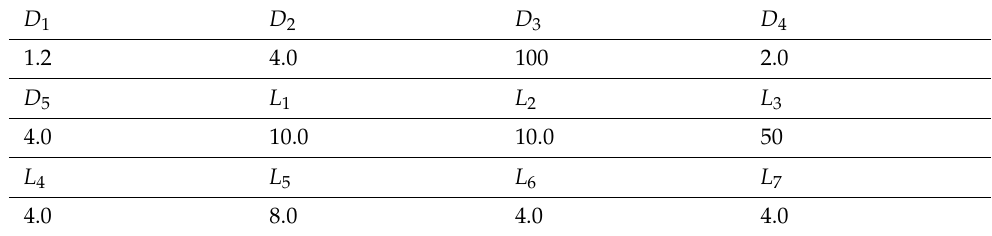
Figure 2. The antenna and the pressurizing device (a syringe pump). For this antenna, the distance L 7 between the two branches, the inner diameter D 4 , and the outer diameter D 5 of the glass tube are all very sensitive dimensions. The initial geometric dimensions in Figure 1 were optimized by the high-frequency structure simulator (HFSS) software. Figure 3 shows the effect of changes in some geometric parameters on the reflection coefficient of the antenna. Figure 3a describes the change curve of the reflection coefficient of the antenna with frequency when the distance between the two branches L 7 increased from 0 to 8 mm, and the outer diameter D 5 = 4.0 mm, and the inner diameter D 4 = 2.0 mm. During this process, the resonant frequency of the antenna dropped a little, and the minimum value of the reflection coefficient also did not change much. As shown in Figure 3b, when the distance between the two branches L 7 = 4.0 mm and the inner diameter D 4 = 2.0 mm, the process of increasing the outer diameter D 5 from 3 mm to 7 mm would cause the reflection coefficient to first decrease and then increase. At the same time, the resonant frequency was also moving to the low frequency. Figure 3c shows the change curve of the reflection coefficient of the antenna when the distance between the two branches L 7 = 4.0 mm and the outer diameter D 5 = 4.0 mm, and the inner diameter D 4 gradually increased from 1.2 mm to 2.8 mm. Obviously, the minimum value of the reflection coefficient increased, and the resonant frequency decreased. Figure 3d shows the change in reflection coefficient when the size of the U-shaped tube remained unchanged and the initial volume of the liquid metal increased (the initial height of L 1 increased). When L 1 increased, the reflection coefficient of the antenna first decreased and then increased, and the impedance bandwidth increased. When L 1 was selected among the values of 8 mm, 9 mm, and 10 mm, the corresponding reflection coefficients of the antenna were the smallest ones. The optimized size adopted in this study was listed in Table 1 through numerical simulation. Table 1. Dimensions of the Optimized Antenna (Unit: